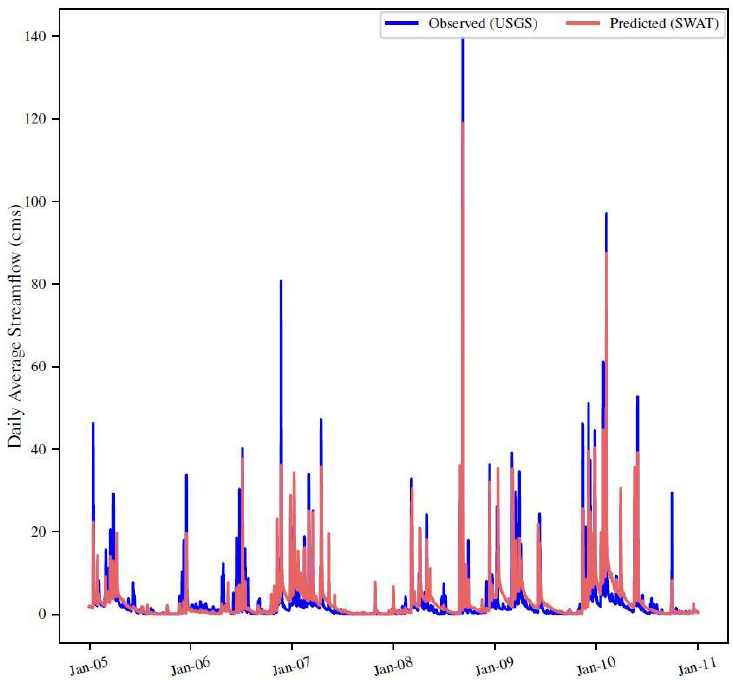
Figure 3. Comparison of observed daily streamflow at the USGS station 02085070 with Soil and Water Assessment Tool (SWAT) simulated daily streamflow.